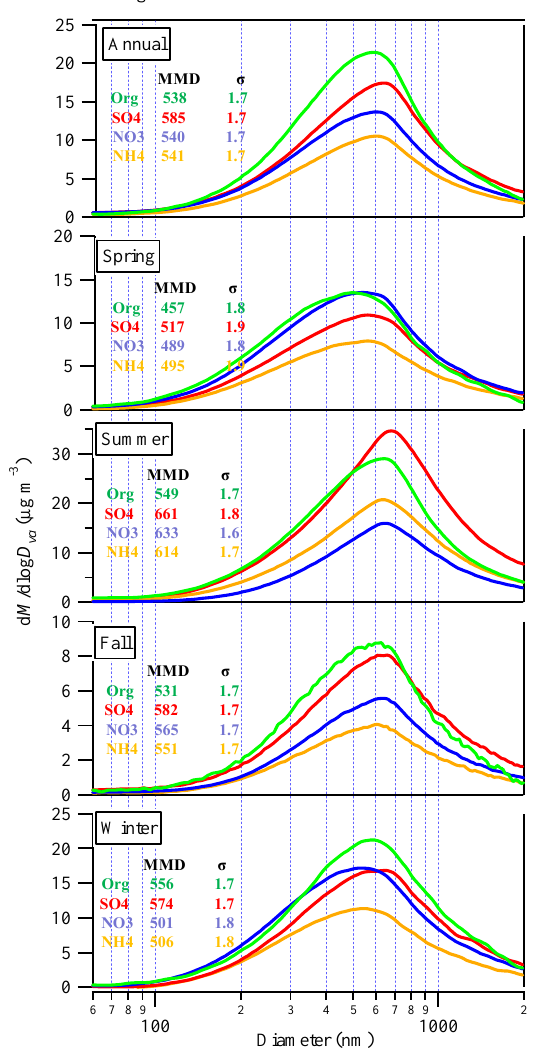
Figure 2. Mass size distributions of chemical species on annual and seasonal scales.